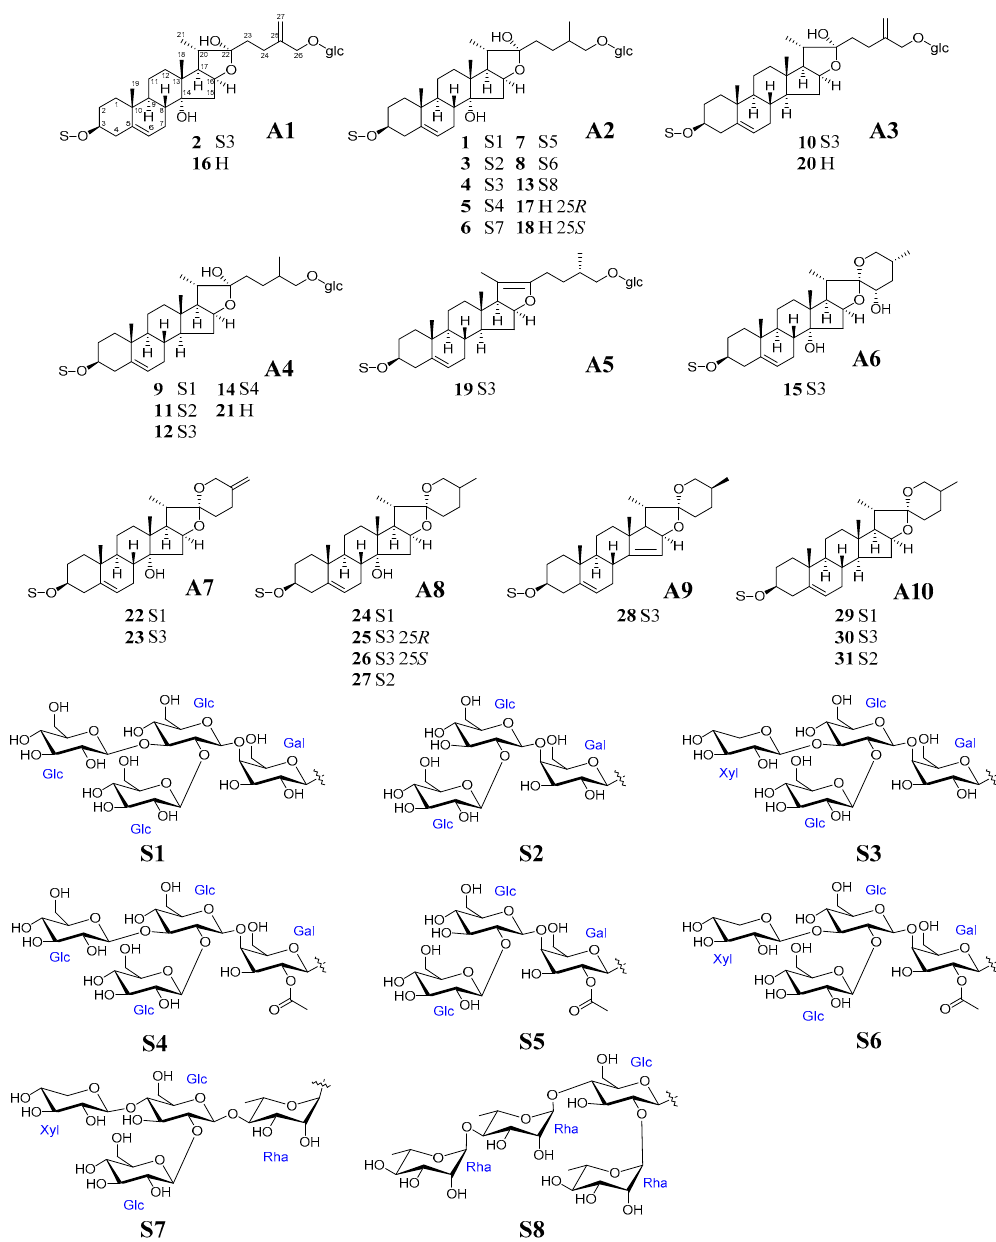
Figure 2. Chemical structures of the steroidal glycosides in Polygonatum species.